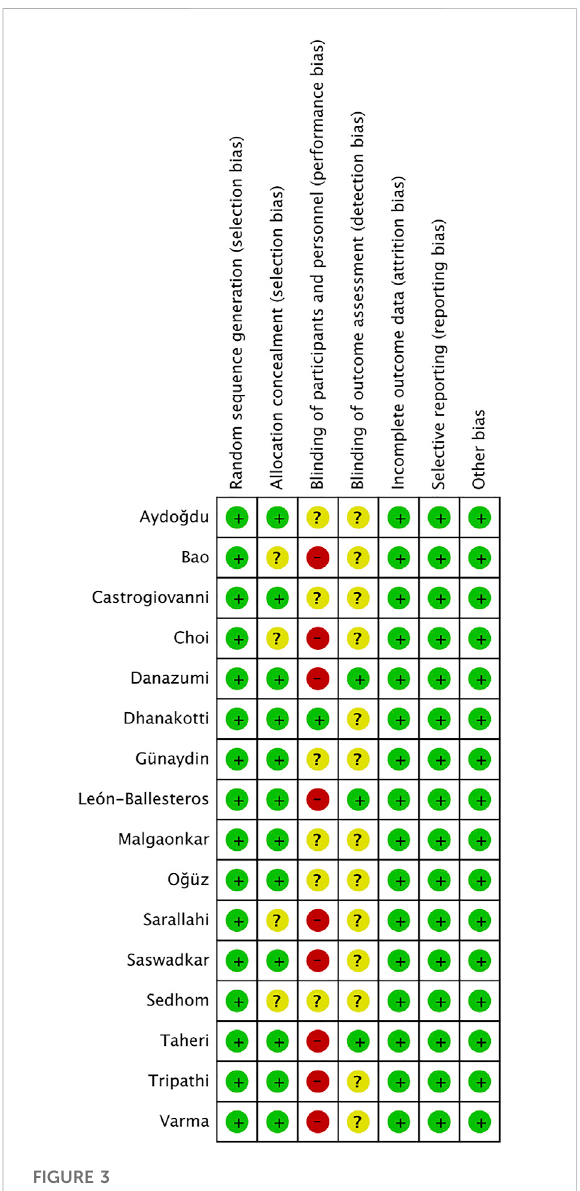
FIGURE 3 Risk of bias summary of included